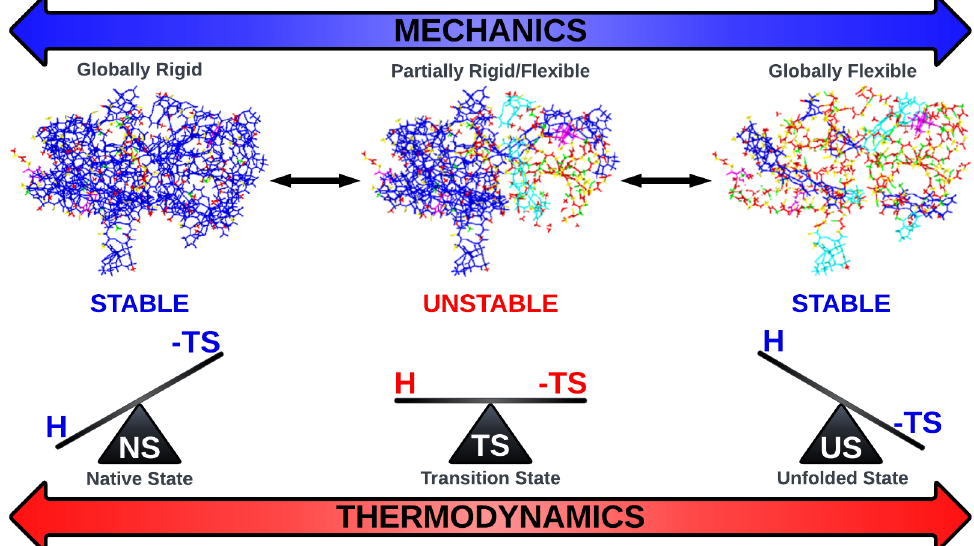
Figure 5. Protein stability paradigm for globular proteins. Mechanical and thermodynamic stability are intimately related. The native state of globular proteins is driven by favorable enthalpic interac- tions through the hydrogen bond network and packing interactions. The unfolded state is driven by conformational entropy, associated with an increase in conformational flexibility. The transition state represents a mixture of opposing thermodynamic and mechanical elements, which determines protein folding